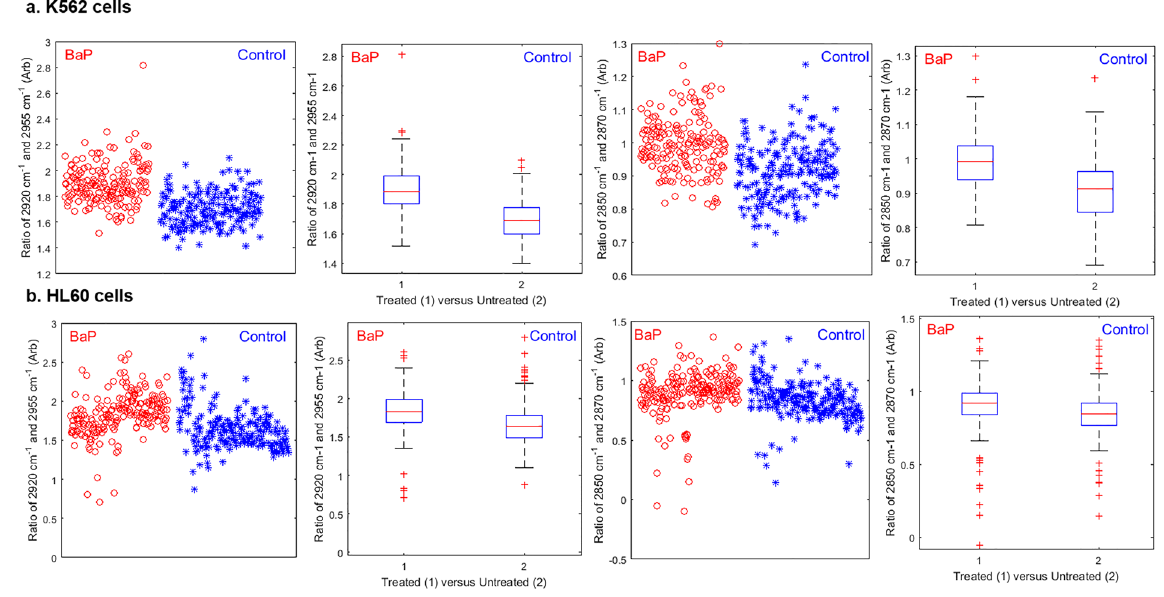
Figure 5. Box and whisker plots for significant changes (p < 0.05, see Supplementary Table S1) in peak area ratios of methylene to methyl stretching vibrations between control and 24 h BaP treated cells analysed by S-FTIR. a. shows peak area ratios 2920:2955 cm − 1 for asymmetric C-H stretching and 2850:2870 cm − 1 for symmetric C-H stretching for K562 cells and b. shows the same ratios for HL60 cells. The median of each box plot can be compared to describe the changes in lipid peak area ratios with drug treatment; with the maximum values, minimum values and outliers showing the spread in inter-cell variability within population sizes of 385 cells for K562 and 441 cells for HL60. Extreme outliers (n < 10) were removed from the plot for visual appearance, however all cells analysed were included in the data